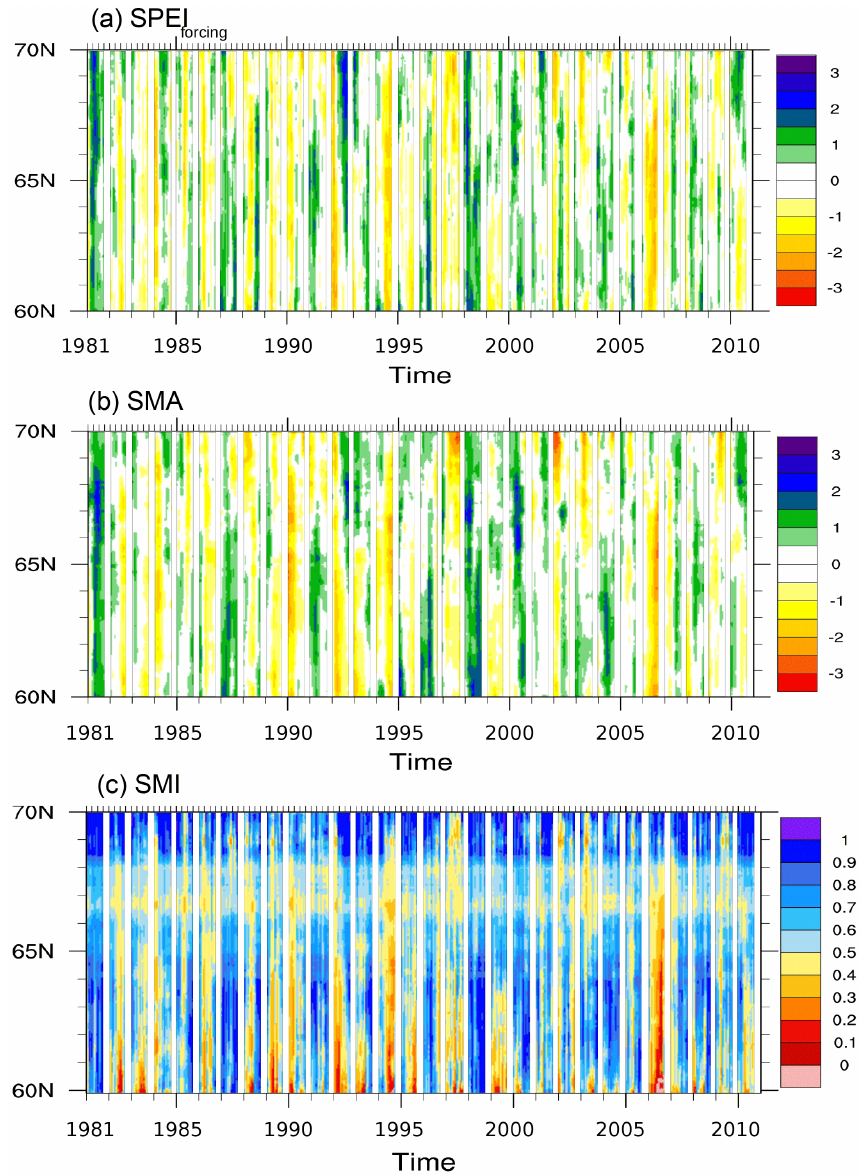
Figure 4. Latitude–time transections of (a) SPEI forcing , (b) SMA, and (c) SMI over Finland in the study period (the summer months (June, July, August) in